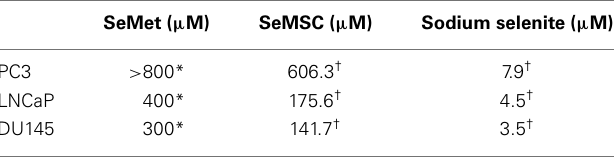
FIGURE 1 | MTT viability assay of selenium treated prostate cancer cell lines . Selenium treatment was maintained for 48h in 10% serum containing conditions and viability was assessed through comparison with metabolic